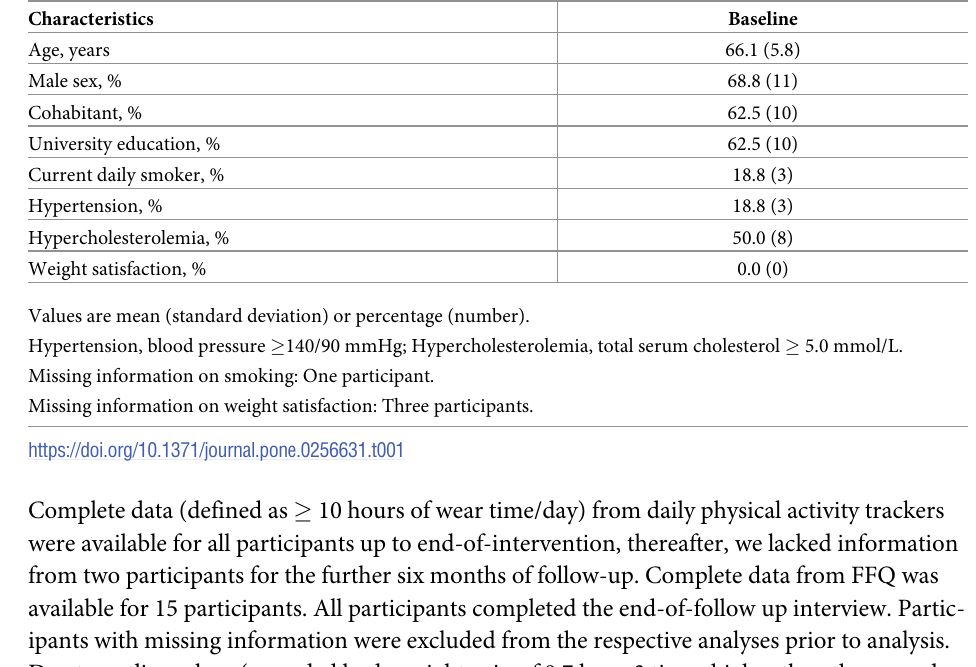
Table 1. Participant characteristics at baseline. The RESTART pilot study